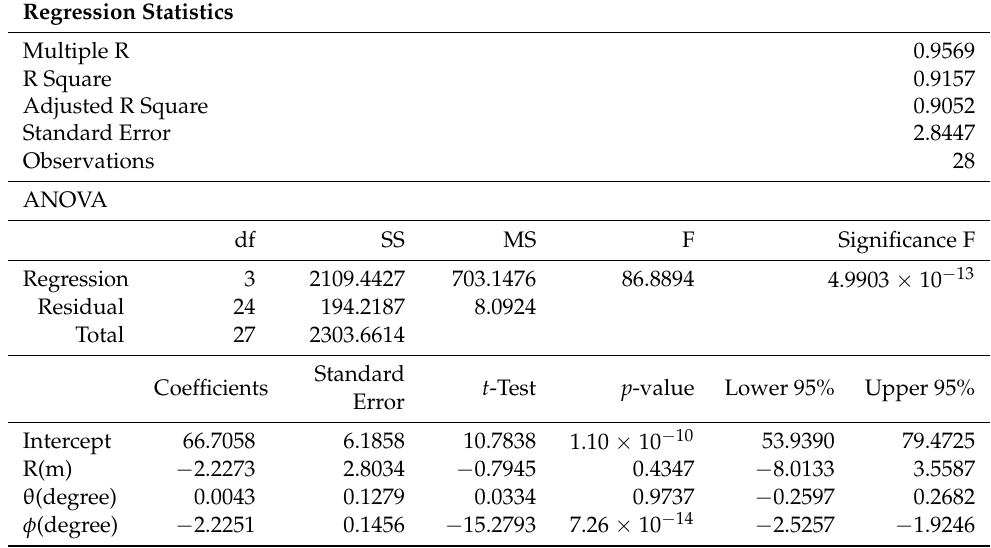
Table 4. Result of complex data